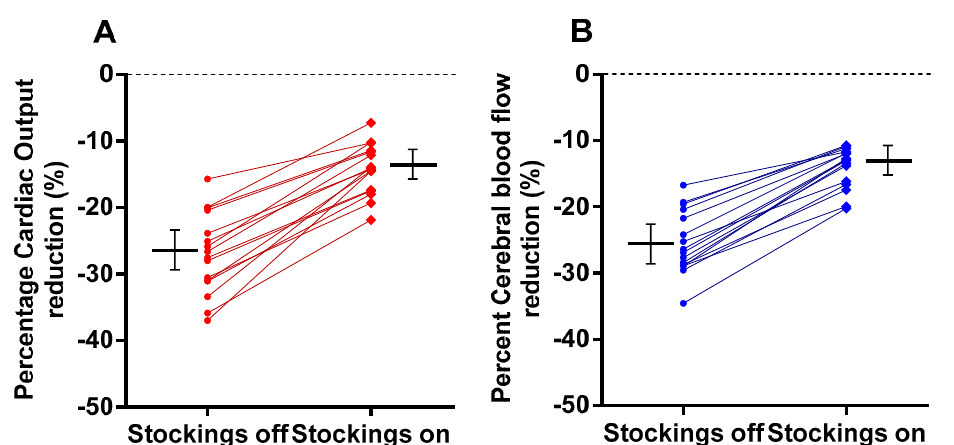
Figure 2. Percentage reduction of cardiac index (panel A ) and percent reduction of cerebral blood flow (panel B ) with stockings off (left side of the graph) and stockings on (right side of the graph). Figure 3 shows the correlation between the percent reduction in CO and the percent reduction in CBF for both stockings off and stockings on. A clear shift to improvement in hemodynamic measurement is shown by the shift towards lower percent reduction in both CO and CBF. The slope of the two correlation lines is not significantly different ( p = 0.94).